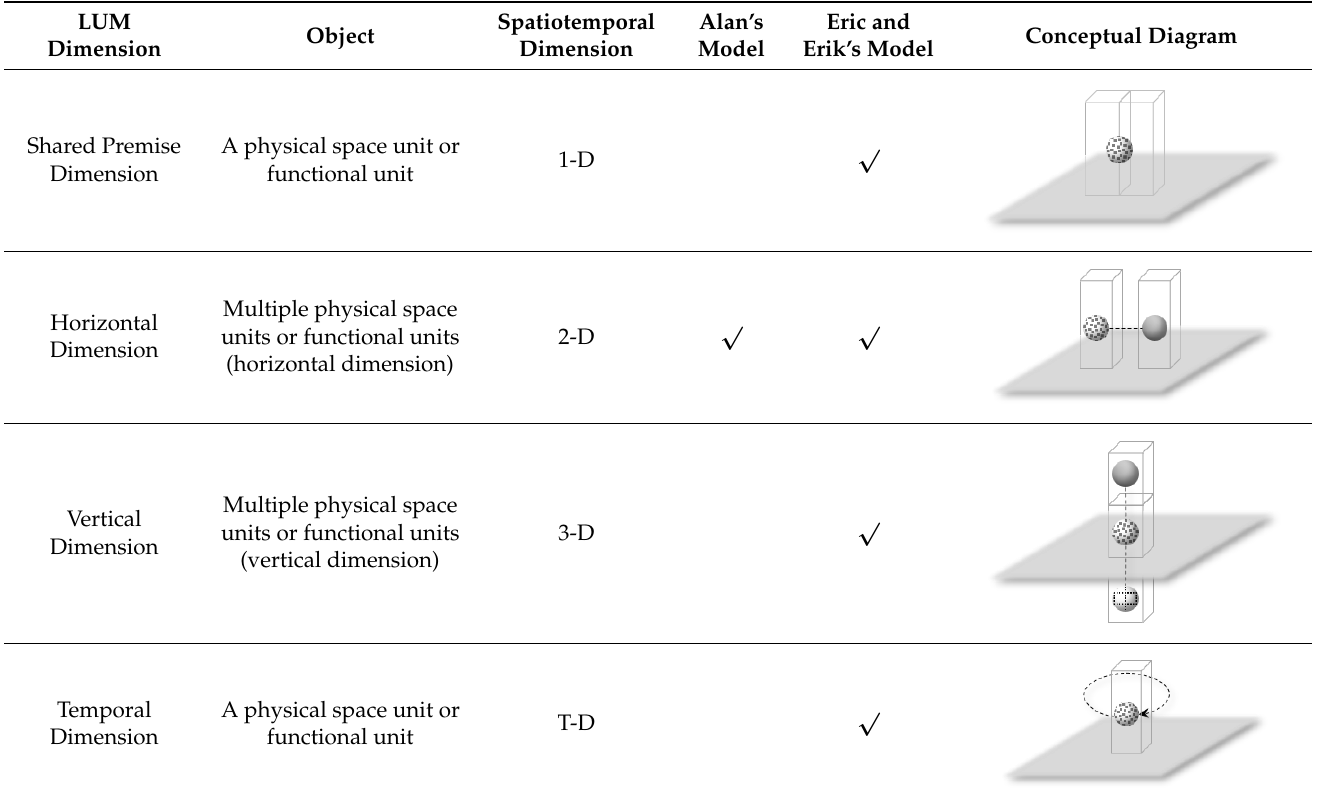
Table 1. Dimension framework of LUM.